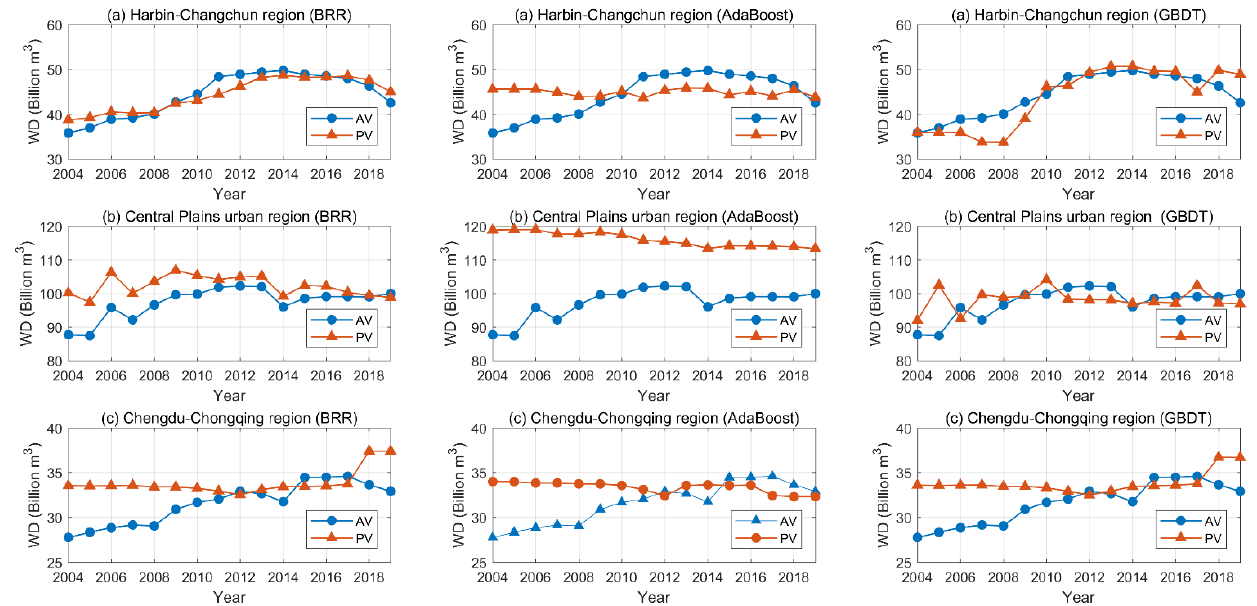
Figure 3. Actual and predicted values of water demand in ( a ) the Harbin–Changchun region, ( b ) the Central Plains urban region, and ( c ) the Chengdu–Chongqing region (WD is the water demand, AV is the actual value, and PV is the predicted value).